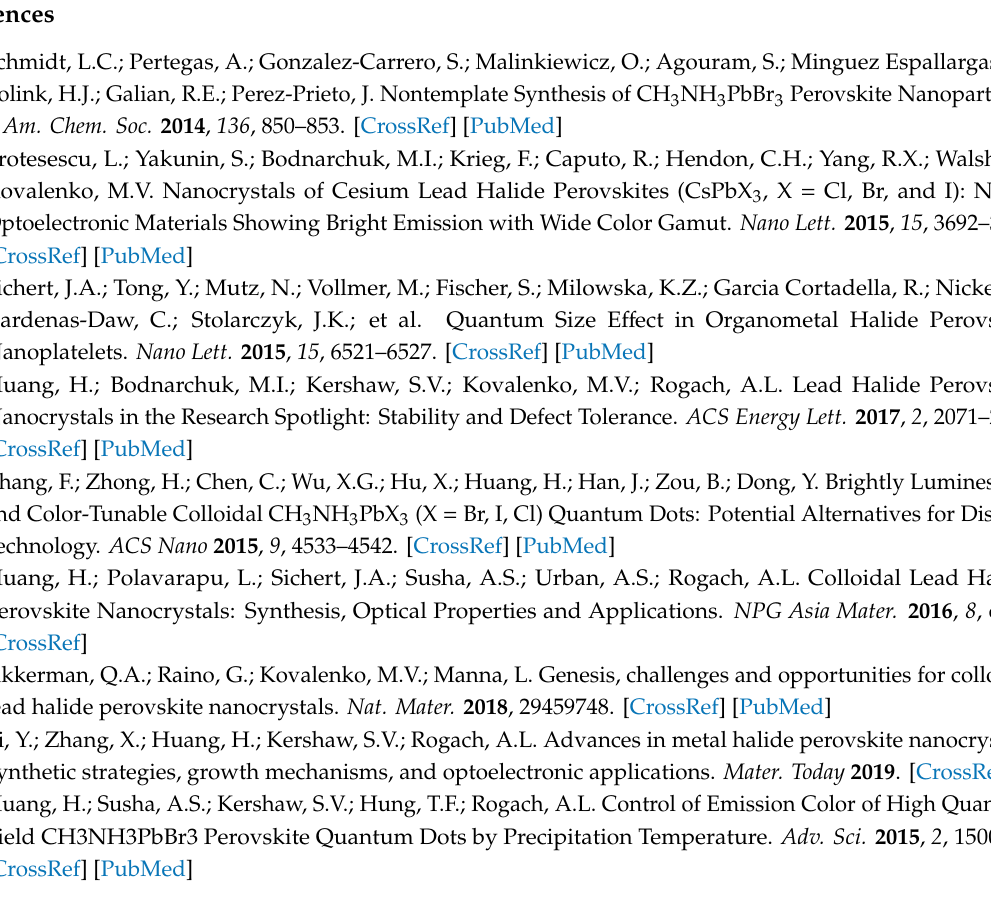
Figure S1: XRD data of FAPbI 3 perovskite nanorods. Figure S2: The stability of FAPbI 3 perovskite nanorods under UV illumination (365 nm, 12W) at ambient conditions: Change in the relative PL intensity of perovskite NC solutions vs UV illumination time. Figure S3: The representative absorption and PL for FAPbI 3 and FAPbBr x I 3-x perovskite